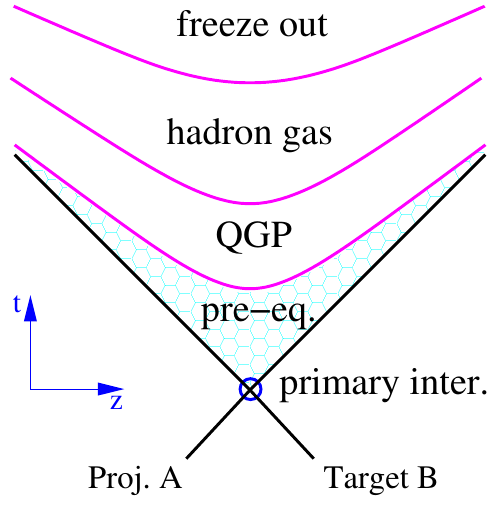
Figure 1. General space-time evolution of particles in hadronic collisions. The combination of QGP and hadron gas apply to the “core” only and the combination of both is called collective